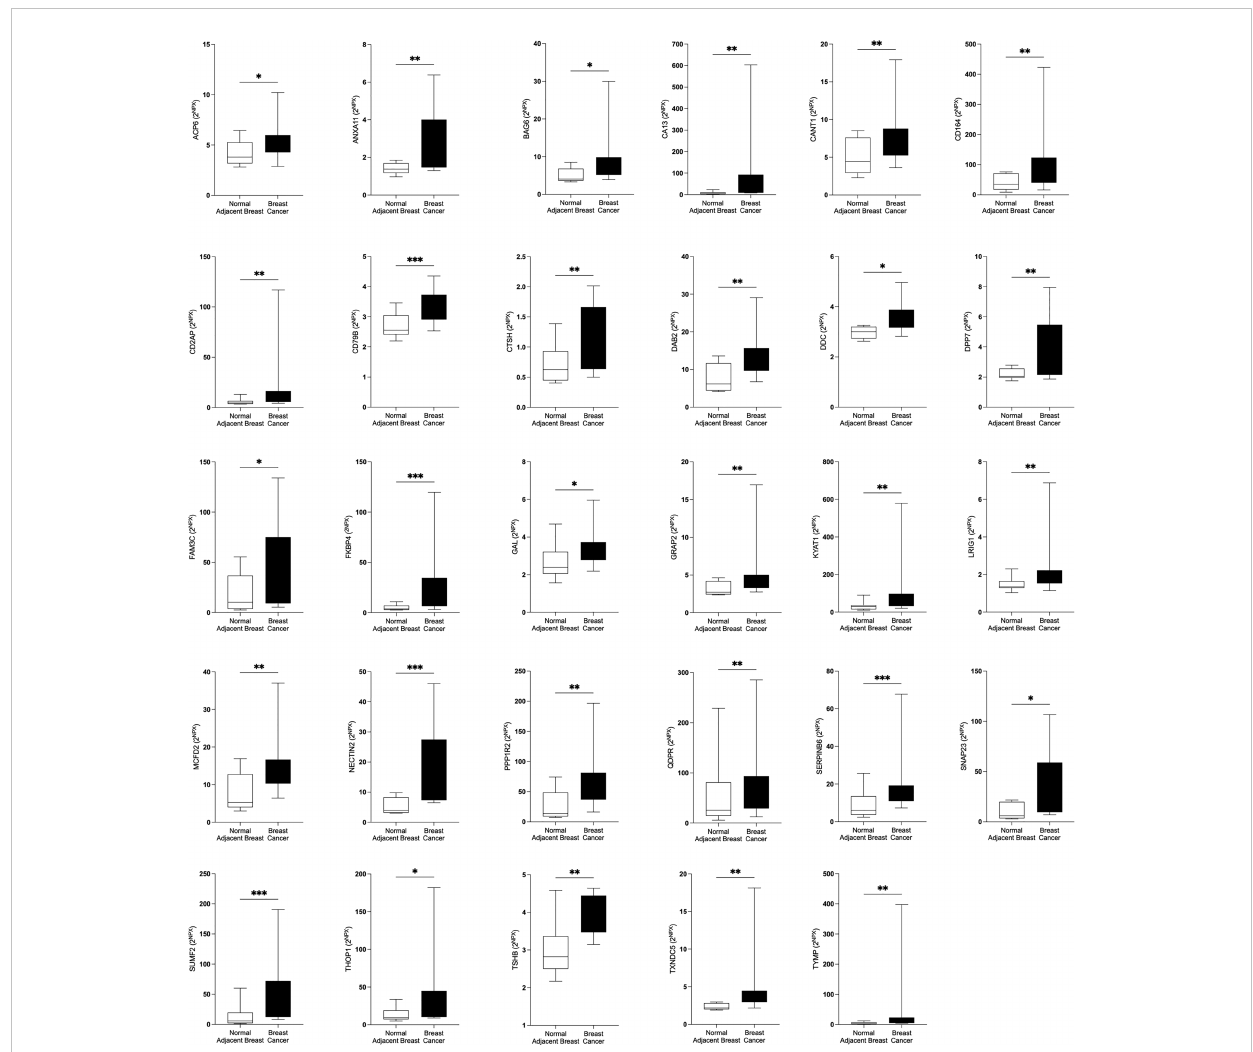
FIGURE 2 Signi fi cantly altered extracellular levels of proteins regulating metabolism in human estrogen receptor positive (ER+) breast cancer in vivo . Twelve patients with breast cancer underwent microdialysis one day prior to their surgery. One catheter was inserted into the breast cancer and another catheter was inserted into normal adjacent breast tissue for in vivo collection of proteins from the extracellular space. The levels of the signi fi cantly altered proteins that were depicted in Figure 1A are shown. Data are presented as box plots with whiskers of min and max values. * P <0.05, ** P <0.01, *** P